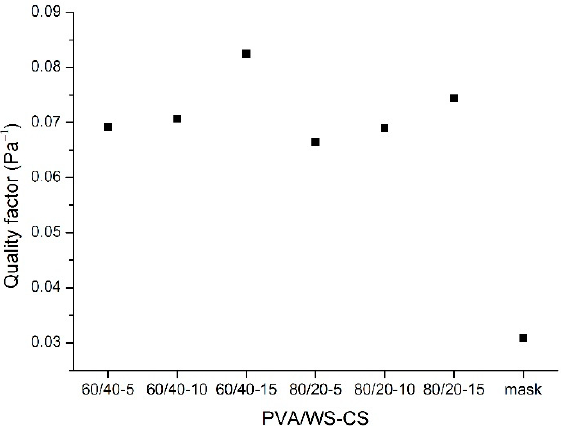
Figure 8. Quality factor of PVA/WS-CS nanofibrous membranes.